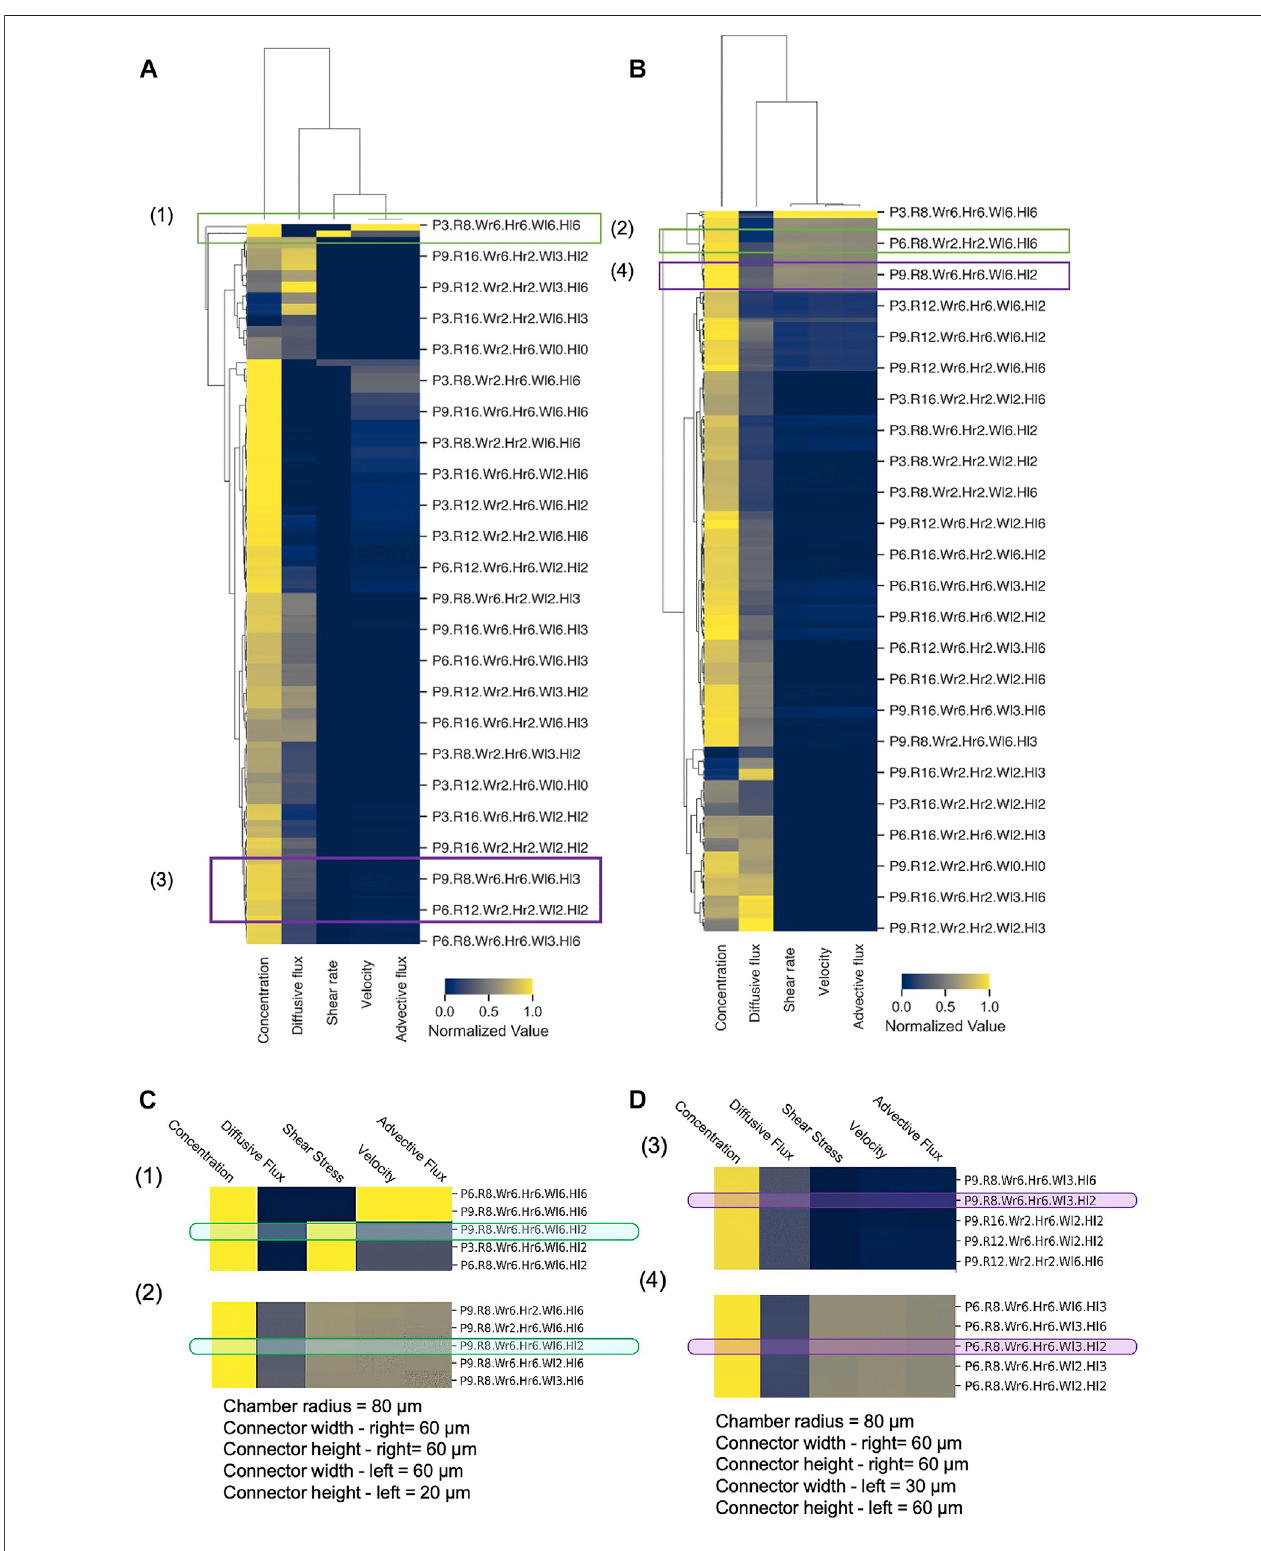
FIGURE 8 | Hierarchical clustering analysis of MF design space. Hierarchically clustered “ design heatmaps ” for (A) Q 1 (cid:2) 2 × Q 2 and (B) Q 1 (cid:2) Q 2 , show normalized values of concentration, shear rate, velocity, and advective and diffusive fl uxes as fi ve key metrics (columns). Independent device designs (rows) are designated by a naming convention, where P (cid:2) Porosity, R (cid:2) Chamber radius, W r (cid:2) Connector width — right, H r (cid:2) Connector height — right, W l (cid:2) Connector width – left, H l (cid:2) Connector